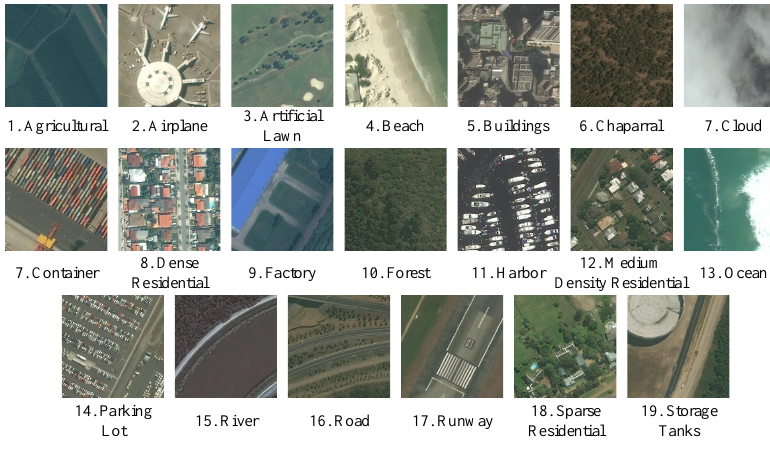
Figure 10. Examples of ImgDB2.